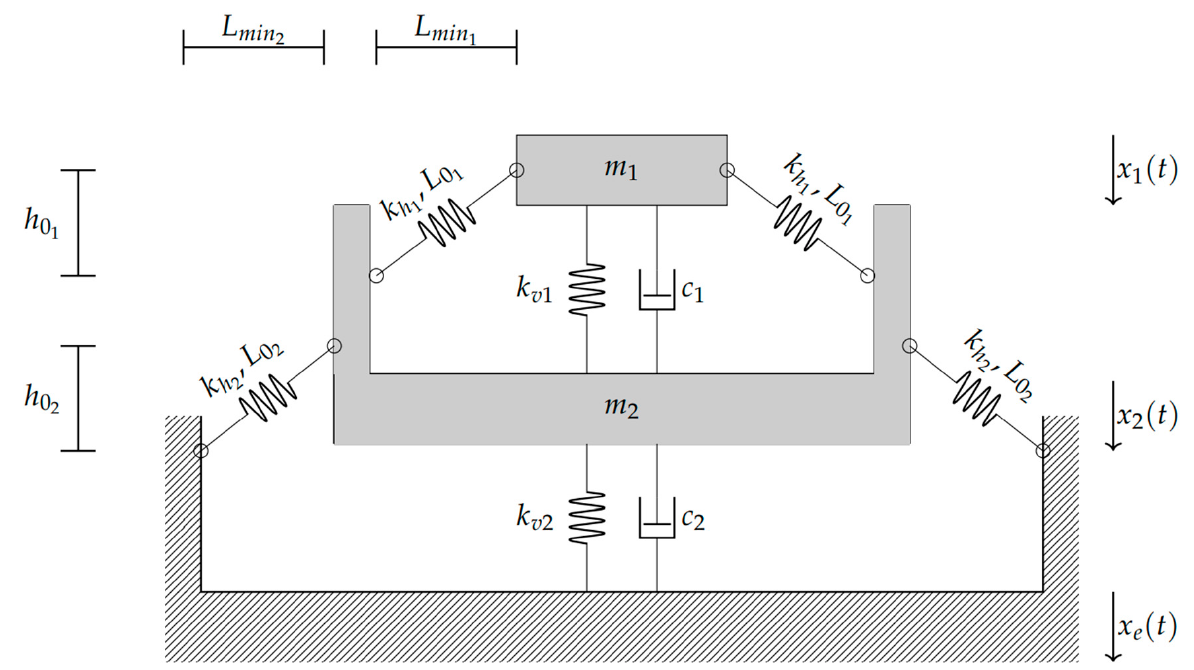
Figure 2. 2DOF QZS system using oblique springs.